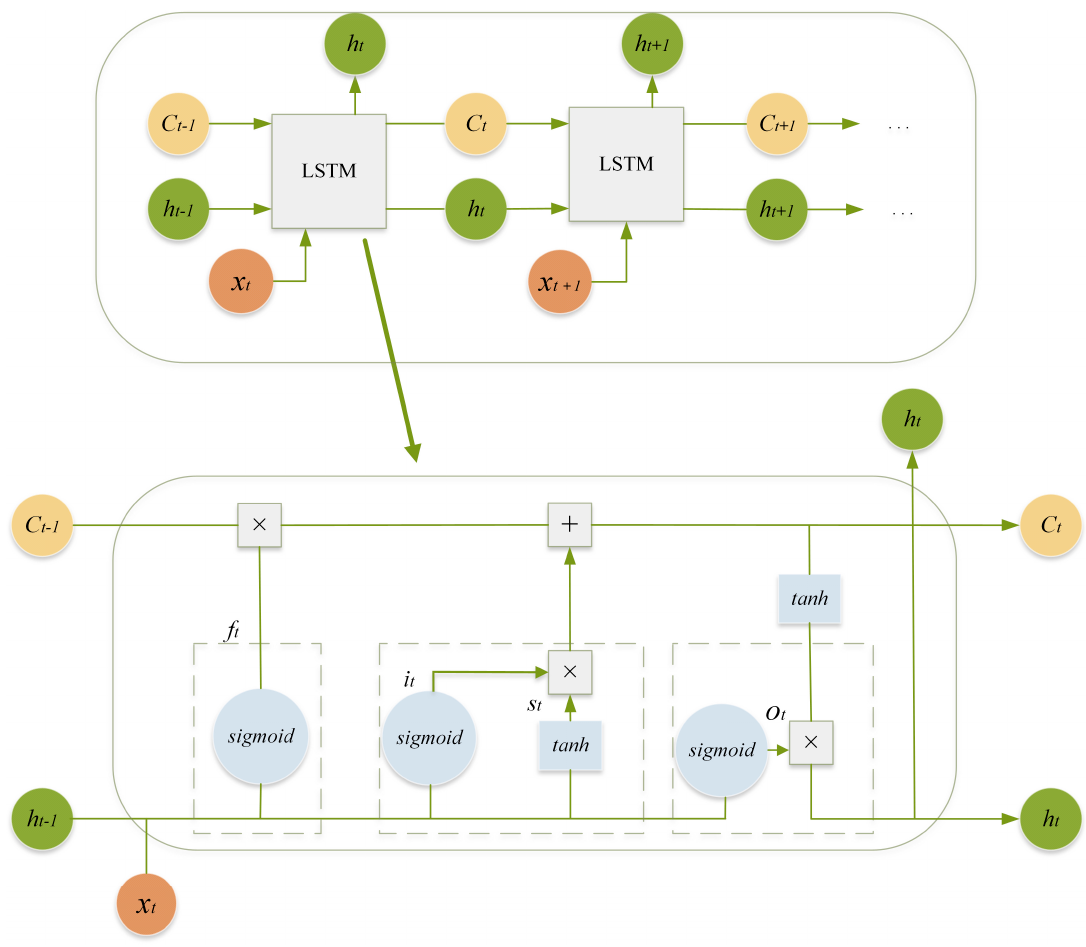
Figure 1. LSTM network structure diagram.